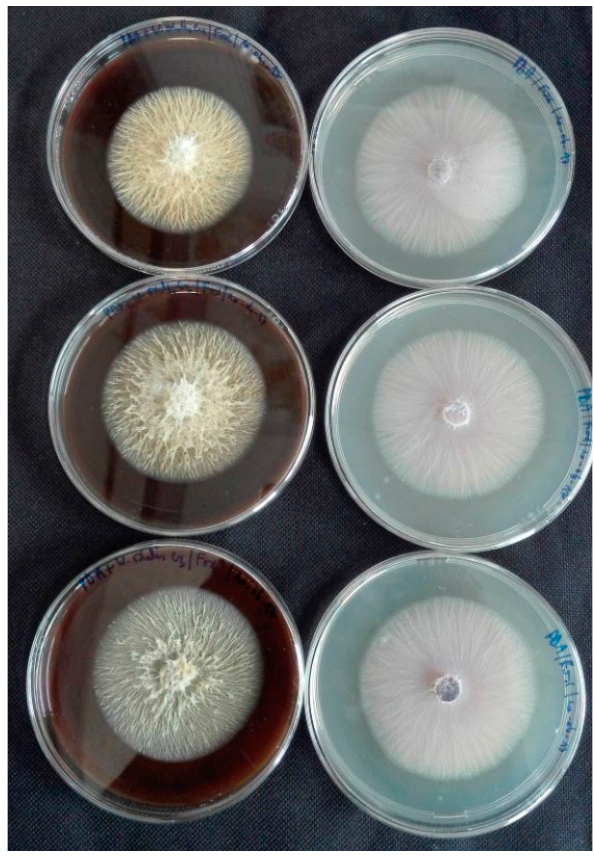
Figure 6. Morphological modification (colour, structure and tex- ture) of Fusarium oxysporum f. sp. vasinfectum growing on modi- fied PDA amended with water extract from Oxalis barrelieri . Left, PDA amended with 5 mg mL -1 of water extract; right, PDA without plant extract.